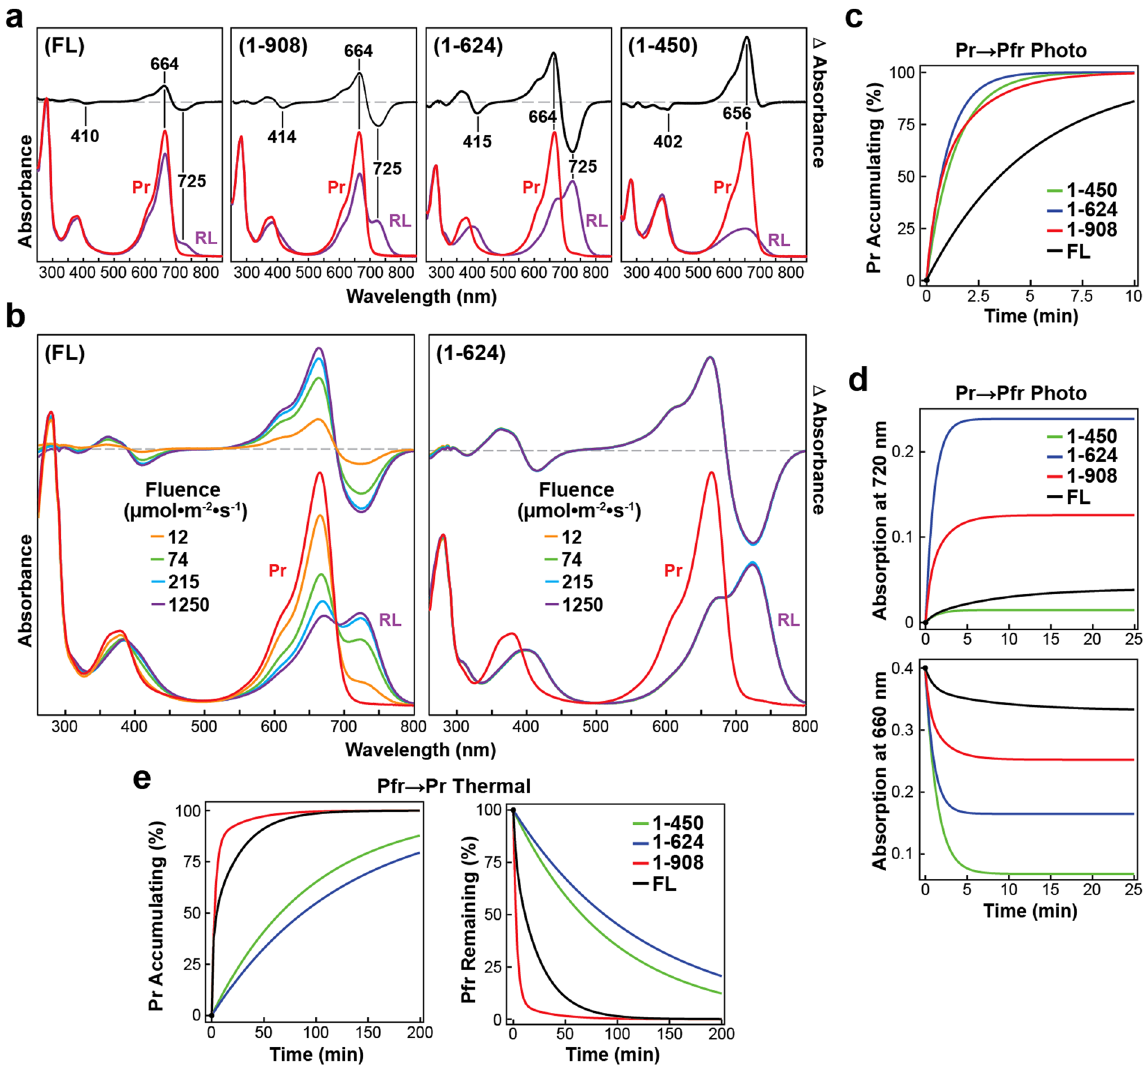
Figure 2. C-terminal truncations of PhyB alter its spectroscopic and kinetic properties. (a) UV-Vis absorption and difference spectra for full-length (FL) PhyB and various C-terminal truncation mutants assembled with P Φ B. Spectra were recorded after dark-adaption (Pr, red) or following irradiation with 12 μ mol ⋅ m − 2 ⋅ s − 1 red light until steady state was reached (RL, purple). The absorption and difference maxima/minima are indicated. The difference spectra are shown at 70% of the total amplitude. Domain organization of the C-terminal truncations assembled are described in Fig. 1a. ( b ) UV-Vis absorption and difference spectra of Pr samples exposed to increasing fluence rates of 660-nm red light. (c) Normalized kinetic profiles of Pr → Pfr photoconversion for samples irradiated with 660 nm light at 12 μ mol ⋅ m − 2 ⋅ s − 1 as monitored at 720 nm. Examples of the raw kinetic traces can be found in Supplementary Fig. S2. (d) Simulated kinetic profiles for photoconversion as monitored by the gain in Pfr absorption at 720 nm (top) or loss of Pr absorption at 660 nm (bottom) to show the relative absorption changes for the samples. (e) Pfr → Pr thermal reversion of the samples as monitored by the gain in Pr absorption at 660 nm (top) and loss of Pfr absorption at 720 nm (bottom). Q band absorption maxima was 0.4 for Pr spectra of ( a , b ). Kinetic traces found in ( c – e ) were calculated from rate constants listed in Table